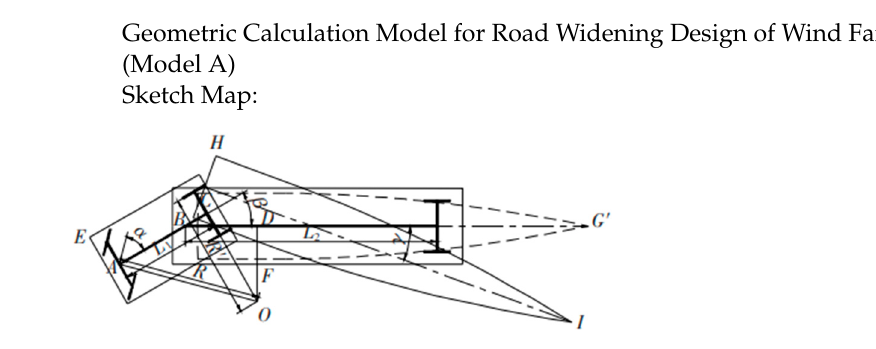
Figure 9. Analysis of road occupation when rotating fan blades.